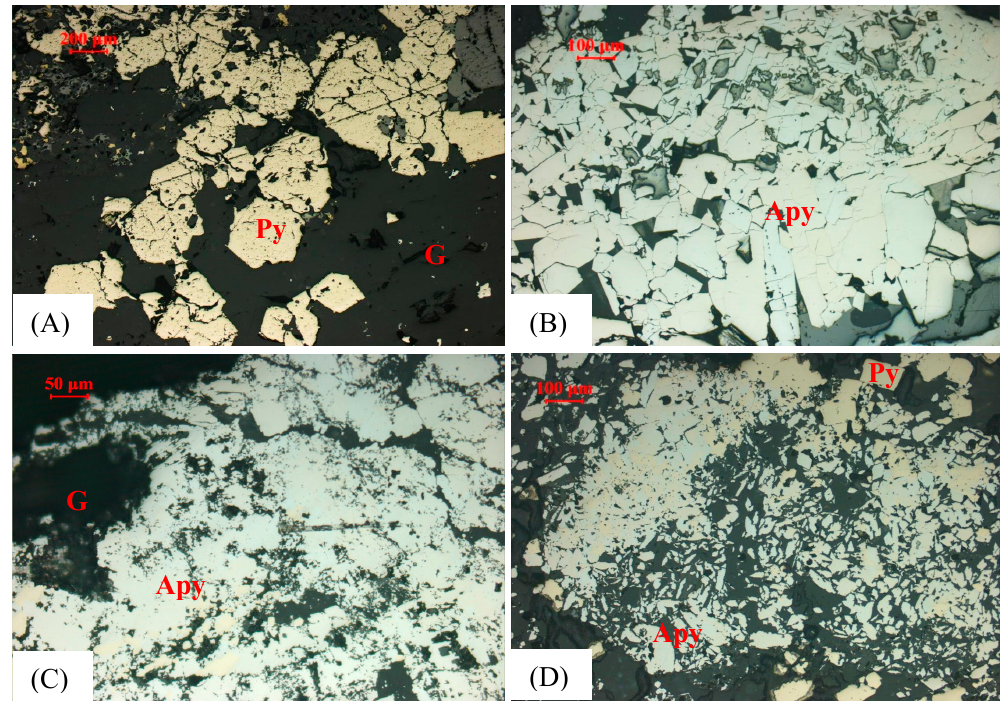
Figure 7. Images of pyrite and arsenopyrite in reflected light: ( A ) pyrite; ( B ) coarse arsenopyrite aggregate; ( C ) fine arsenopyrite aggregate; ( D ) an aggregate of pyrite and arsenopyrite (Py—pyrite; Apy—arsenopyrite; G—gangue).